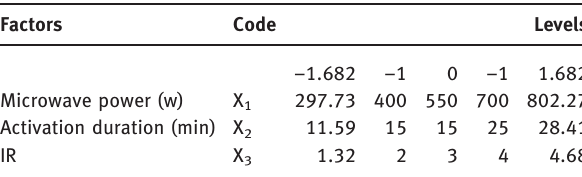
Table 1: Independent variables and their levels used for central composite rotatable